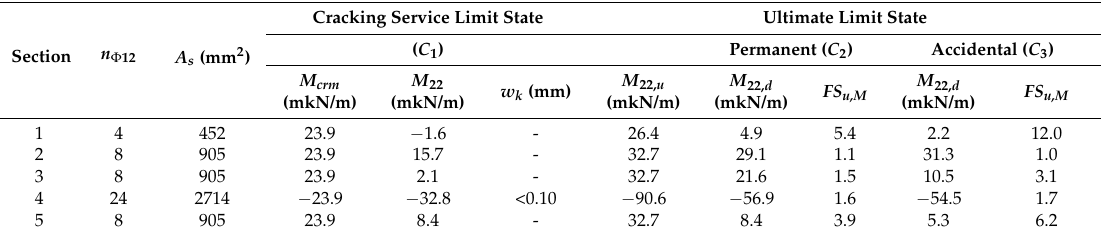
Table 1. Cracking service limit state and bending ultimate limit state checks for the control sections.